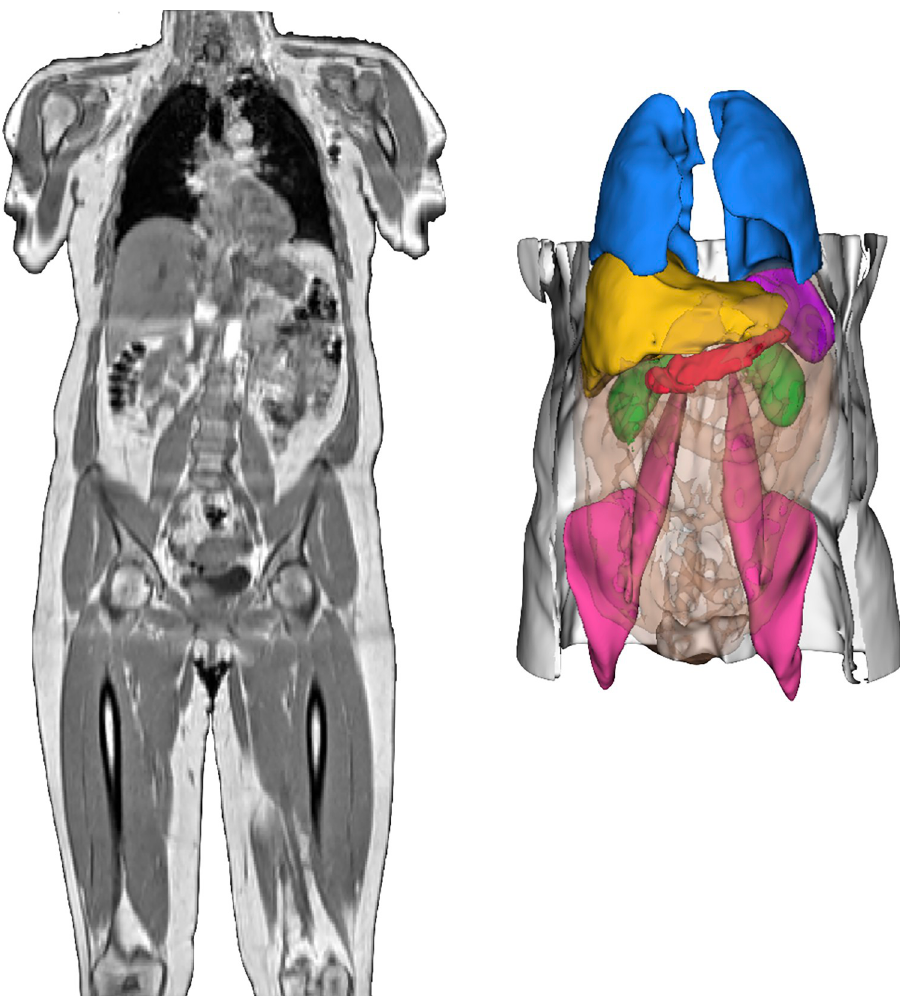
Fig 1. Neck-to-knee UK Biobank MRI acquisition of a COVID-19 study participant and 3D renderings of image- derived phenotypes. These were obtained after image preprocessing and segmentation pipelines for that same participant. 3D segmentations: Liver (yellow), lungs (blue), spleen (purple), kidneys (green), abdominal subcutaneous adipose tissue (white), visceral adipose tissue (orange transparent), iliopsoas muscles (pink), pancreas (red).